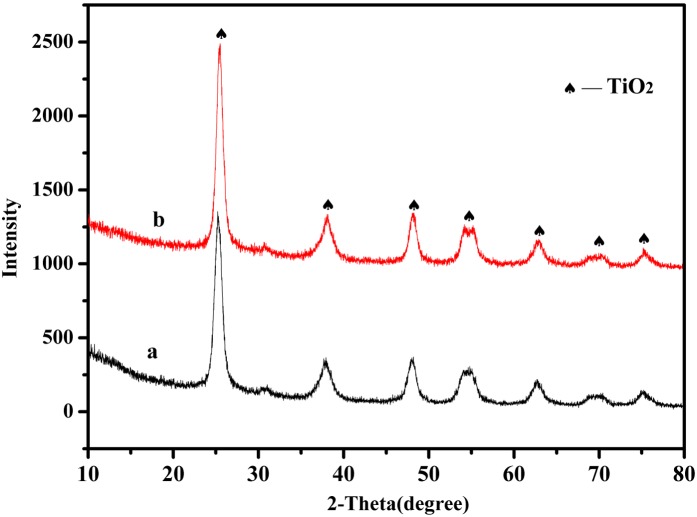
XRD patterns of CuS-GeO2-TiO2 composite coating (a) and TiO2 (b).